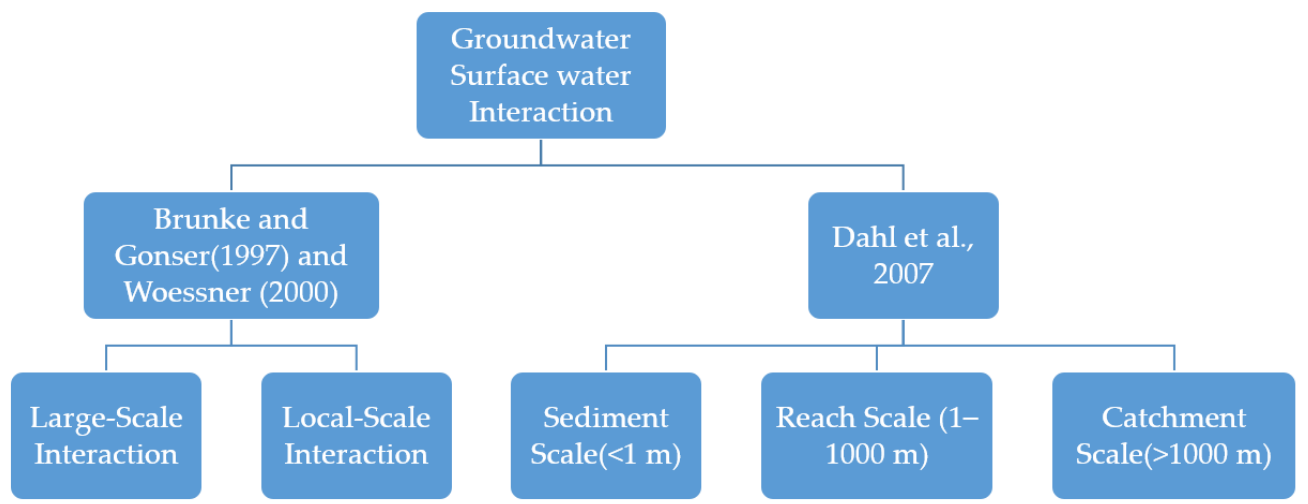
Figure 3. Different groundwater–surface water interaction scales studied through different ap- Figure 3. Di ff erent groundwater–surface water interaction scales studied through di ff erent ap- proaches proaches [50–52].